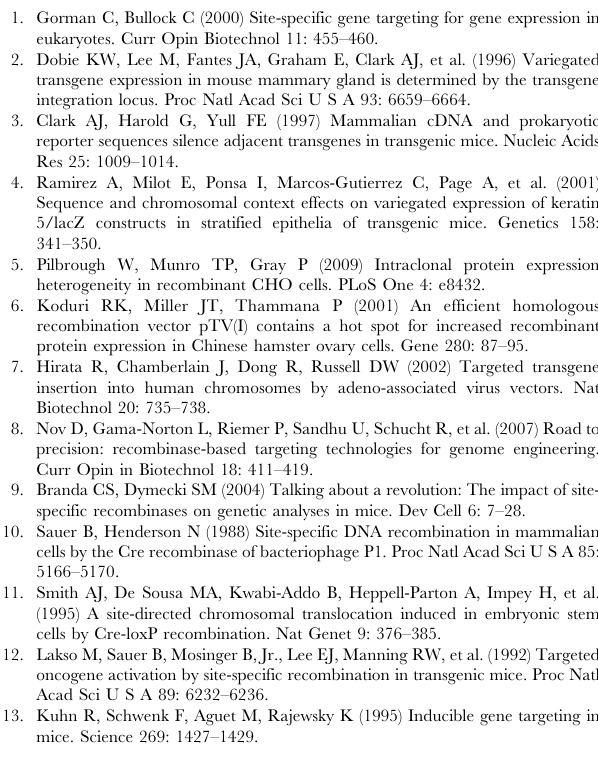
Figure S3 Nucleotide sequence of mammalian codon- optimized TP901-1 integrase. The nucleotide sequence of TP901-1 integrase used in this study. A mammalian codon- optimized TP901-1 integrase gene was synthesized de novo according to the native TP901-1 integrase amino acid sequence. (DOC) Figure S4 Nucleotide sequence of mammalian codon- optimized Bxb1 integrase. The nucleotide sequence of the Bxb1 integrase used in this study. A mammalian codon-optimized Bxb1 integrase gene was synthesized de novo according to the native Bxb1 integrase amino acid sequence. Table S1 Sequence of the attP, attB and FRT sites used in this study. Table S2 The PCR primers used in this